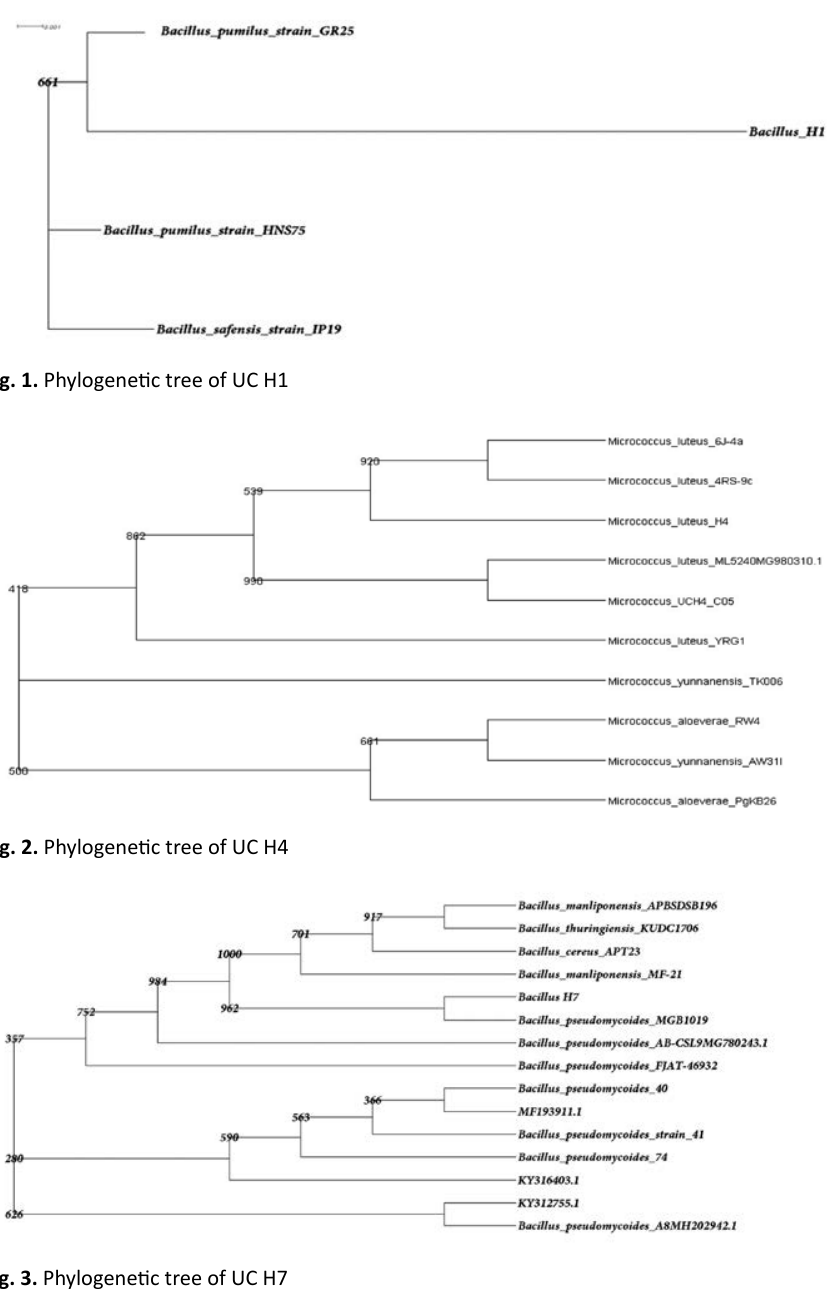
Fig. 3. Phylogenetic tree of UC